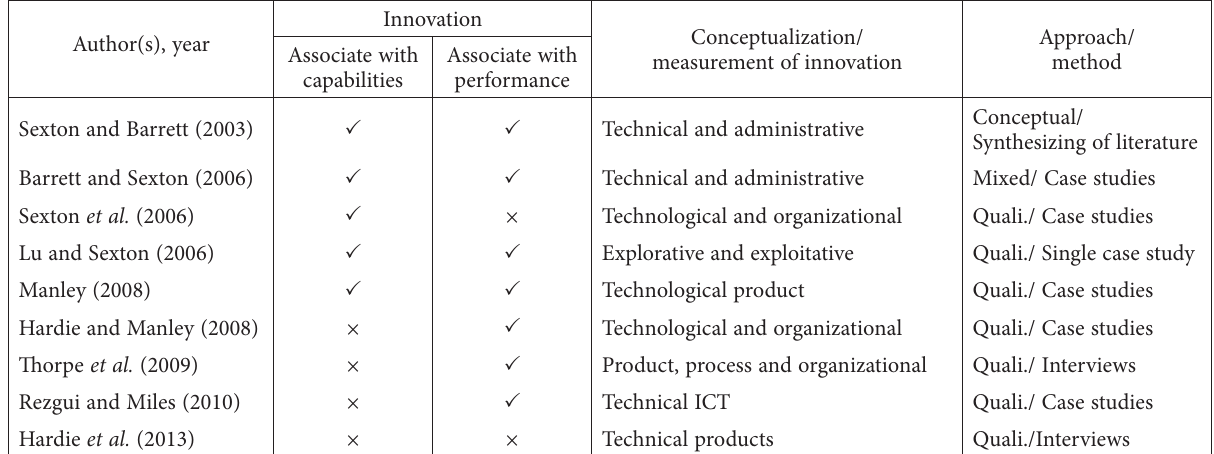
Table 1. A summary of studies on innovation in